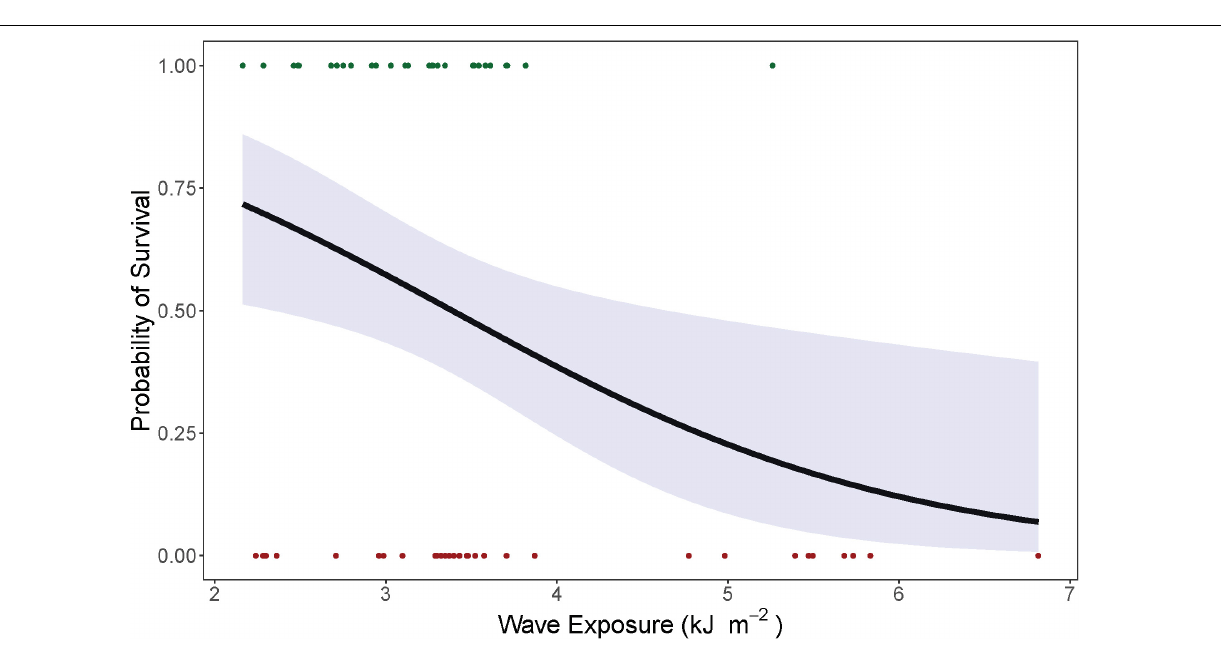
FIGURE 3 | Logistic regression (black line) showing the effect of wave energy (kJ m - 2 ) on the probability of survival of Acropora cervicornis outplants in 7 subregions along the Florida reef tract, United States from 2012 to 2018—based on reefs with the highest likelihood of survival (green dots) and the lowest likelihood of survival (red dots). The 95% confidence intervals are shown in